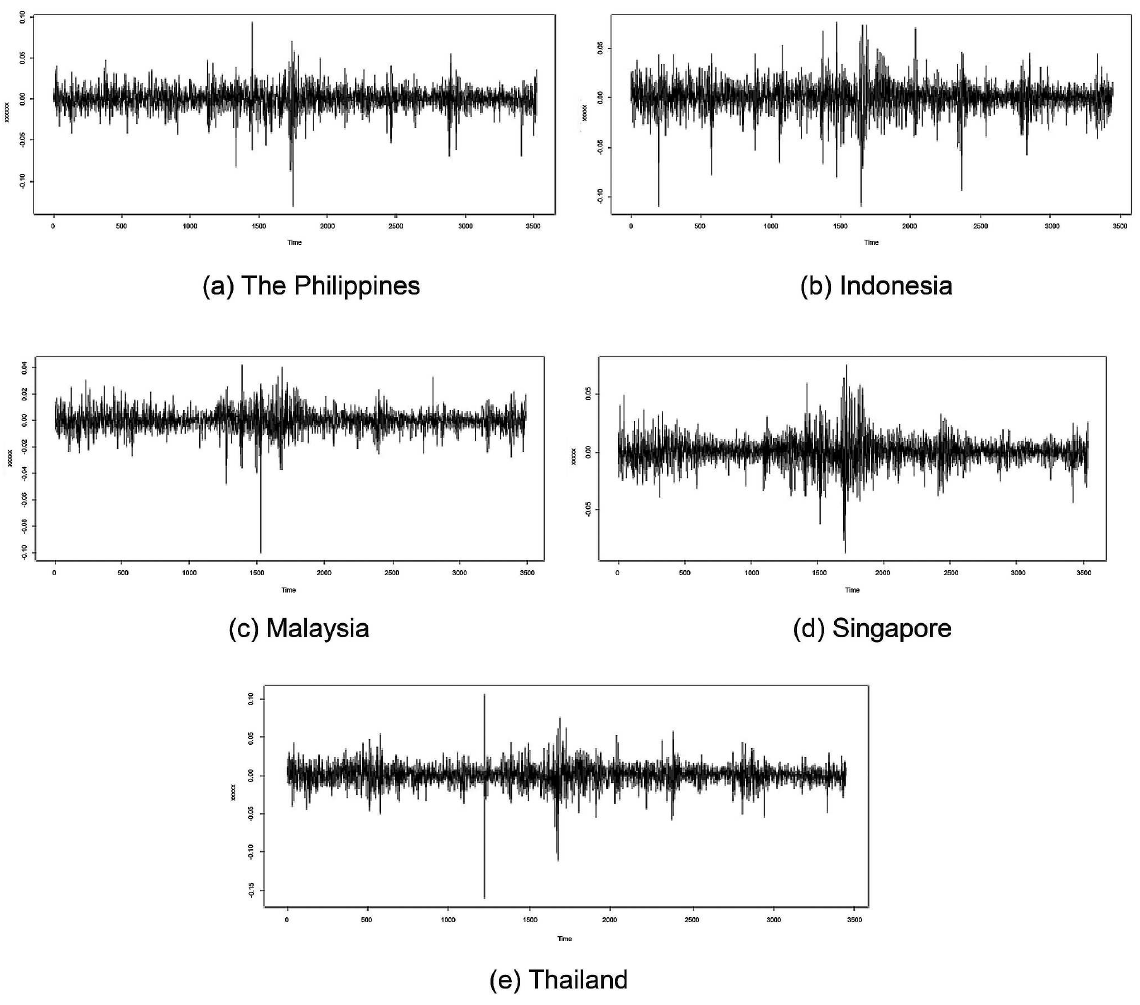
Figure 1. The return index of (a) the Philippines, (b) Indonesia, (c) Malaysia, (d) Singapore, and (e) Thailand (January 1, 2002 – January 31,